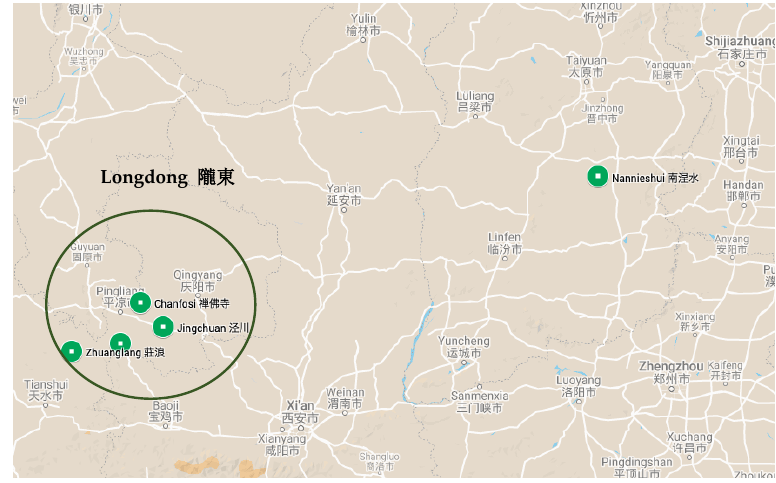
Figure 1. Map of Eastern Gansu, Shaanxi, and Shanxi province.